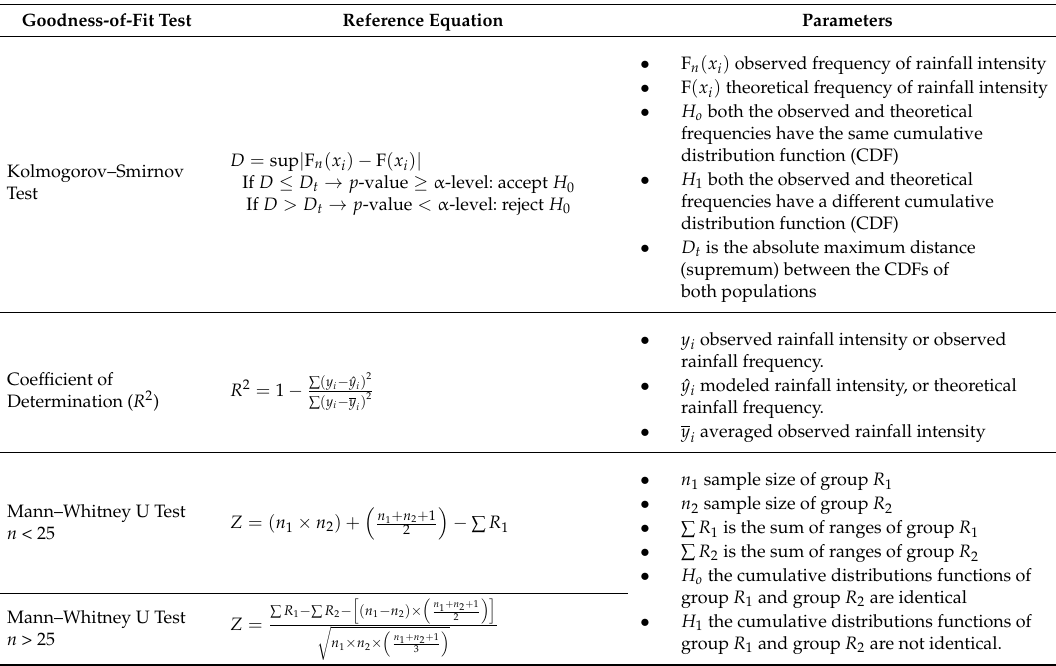
Table 3. Goodness-of-fit tests used in WEBSE IDF